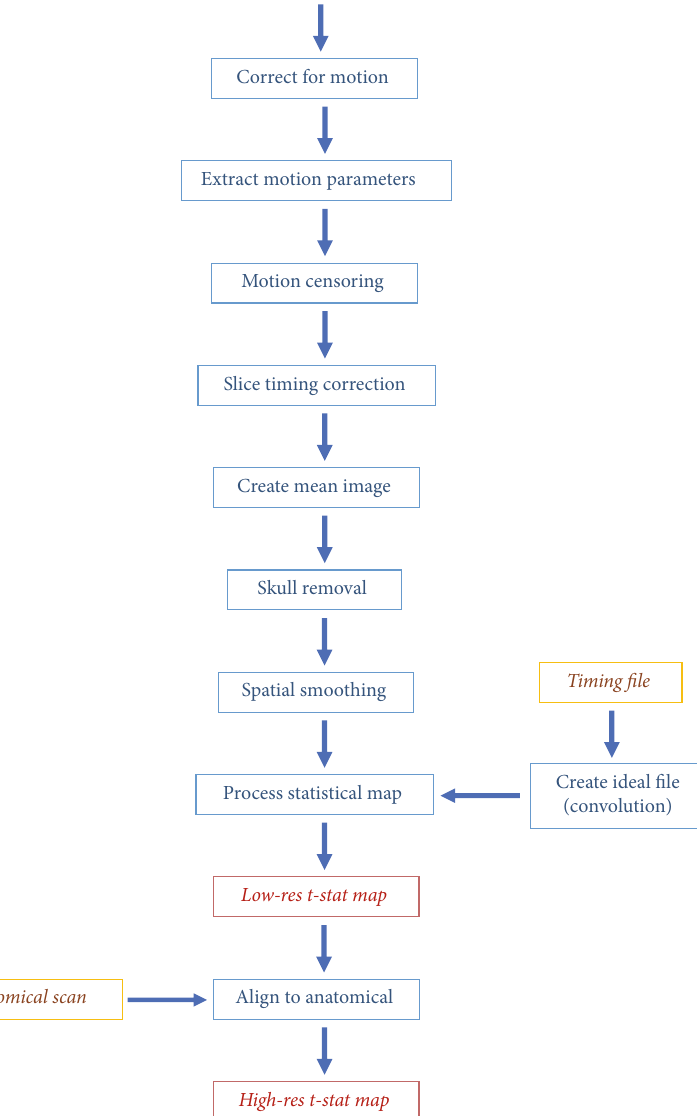
Figure 2: Processing pipeline used to analyze both fMRI